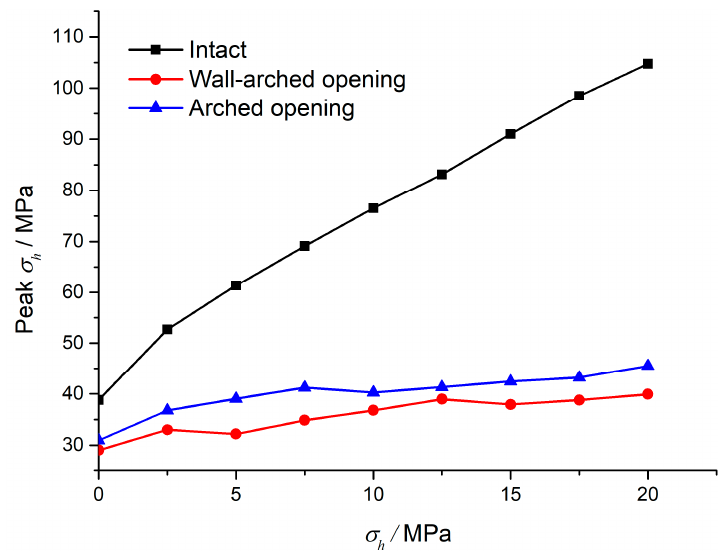
Figure 12. Axial stress-strain curves for specimens with different openings.